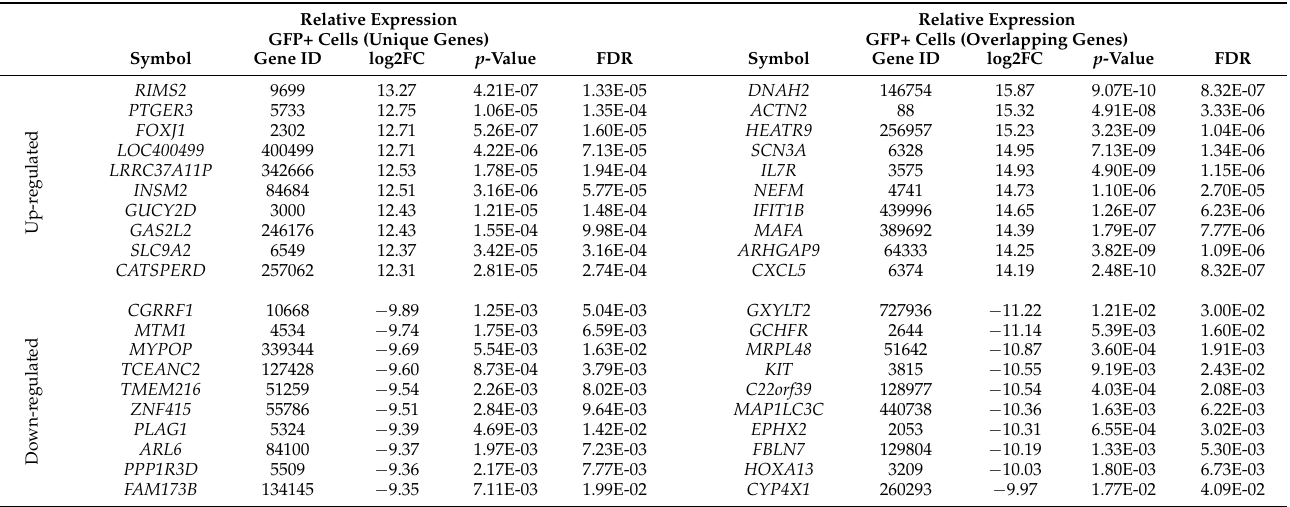
Table 1. Top ten up- and down-regulated differentially expressed genes in GFP+ cells (RRV-infected) based on their log2FC